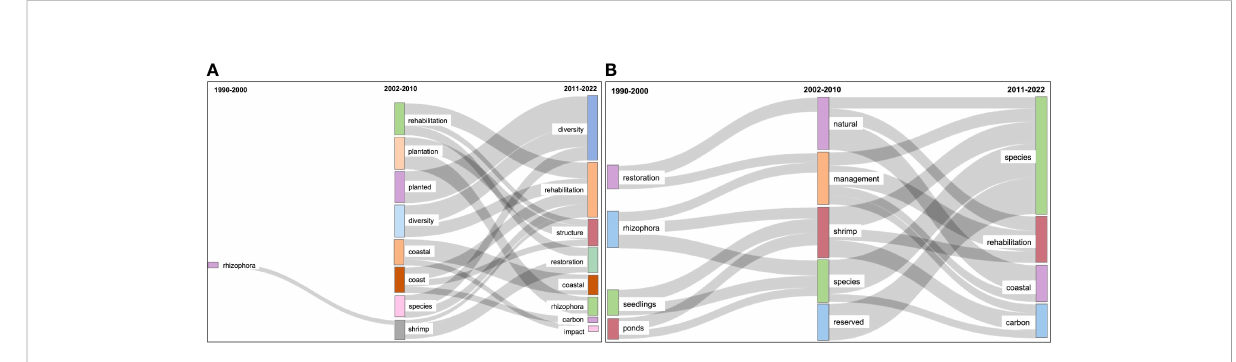
FIGURE 8 Thematic evolution using (A) titles and (B) abstracts.